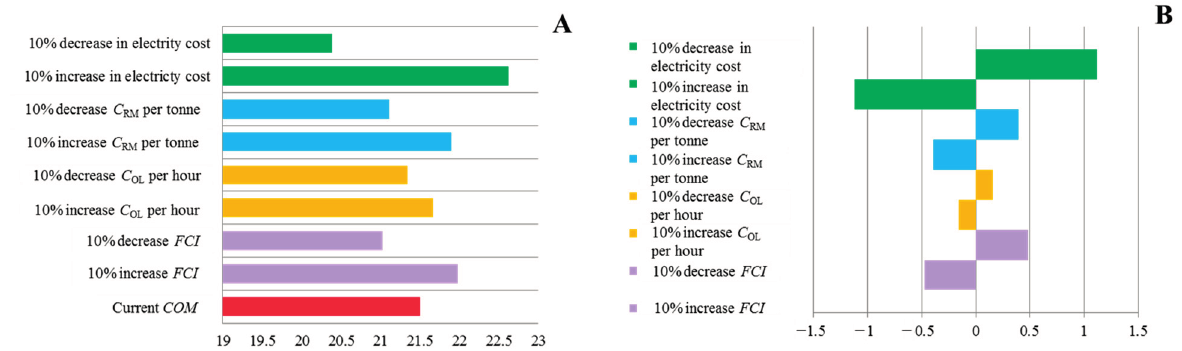
Figure 4. Cost of manufacture ( COM ) kg − 1 of maize wax leaf pellets: ( A ) Difference in COM (€) when varying the different parameters (electricity cost, C RM , C OL and FCI ) by 10% (increase or decrease); and ( B ) % difference in COM when varying the different parameters by 10% (increase or